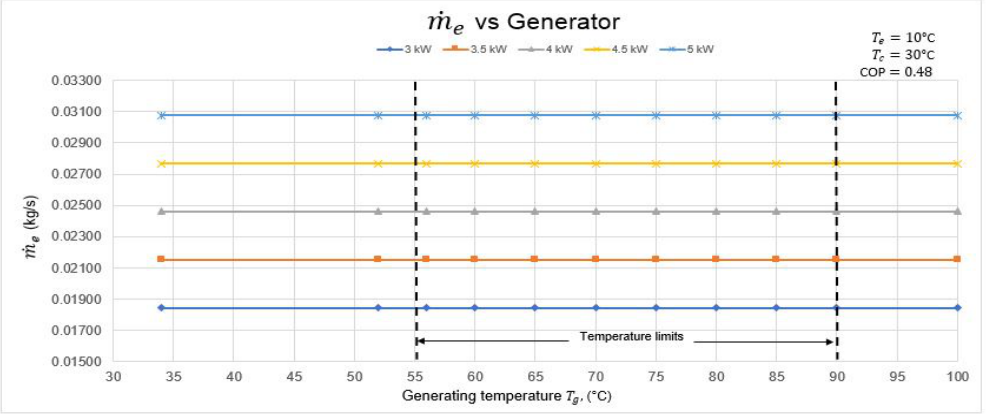
Figure 8. Mass flow of the evaporator ( ˙ m e ) considering five powers (kW).